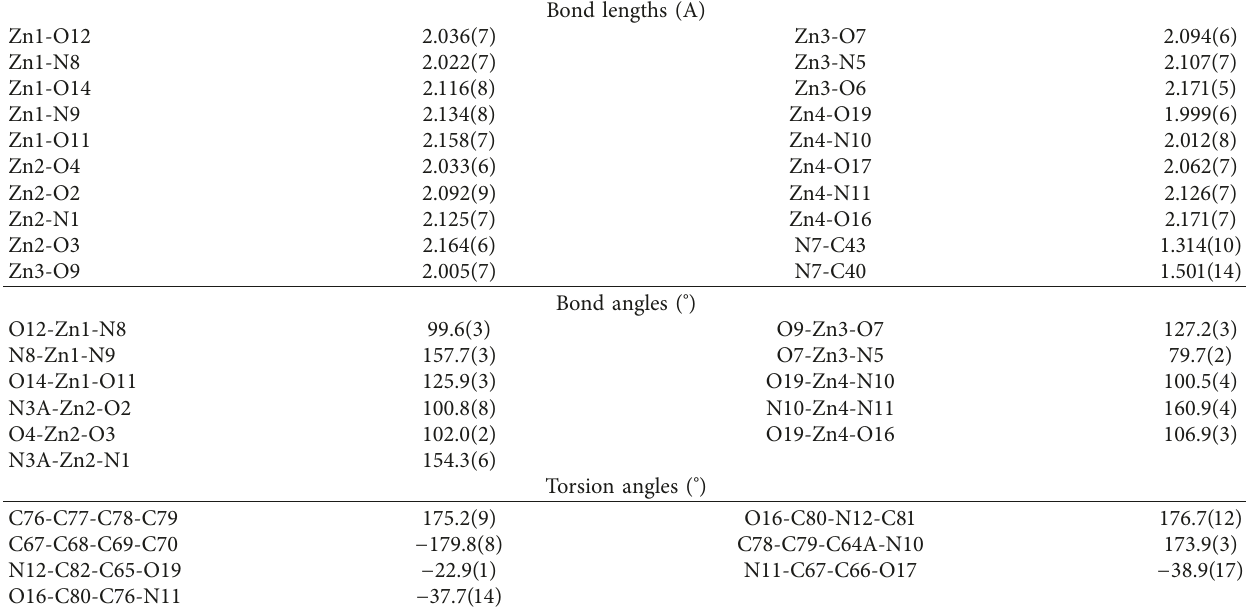
Figure 7: The carbon and nitrogen atoms with order and disorder effects in LISZn2. Anisotropic displacement ellipsoids are drawn at the 30% probability level. In order to clarify, some atoms are omitted. Table 3: Selected bond lengths (˚A) and angles ( ° ) of the LISZn2 compound.